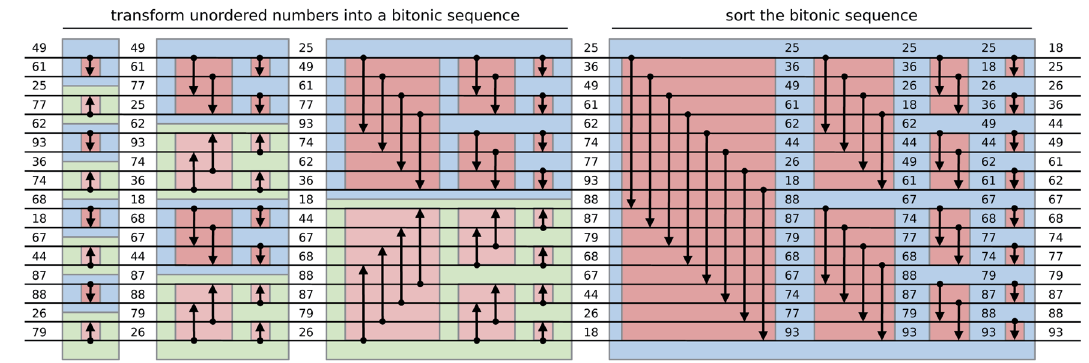
Figure 3. Sorting network for the bitonic sort. Each horizontal line represents an input and each arrow represents a two-input/two-output comparator which performs compare-exchange operation. Depending on its direction, the outputs are sorted in increasing (decreasing) order with a downwards (upwards) arrow. First, the comparator network transforms an input sequence of 16 unordered numbers into a bitonic sequence alternating  bitonic merges. Then, the obtained bitonic sequence is sorted with BM ⊕ (adapted from Grama et al. a recursive bitonic merge procedure 16